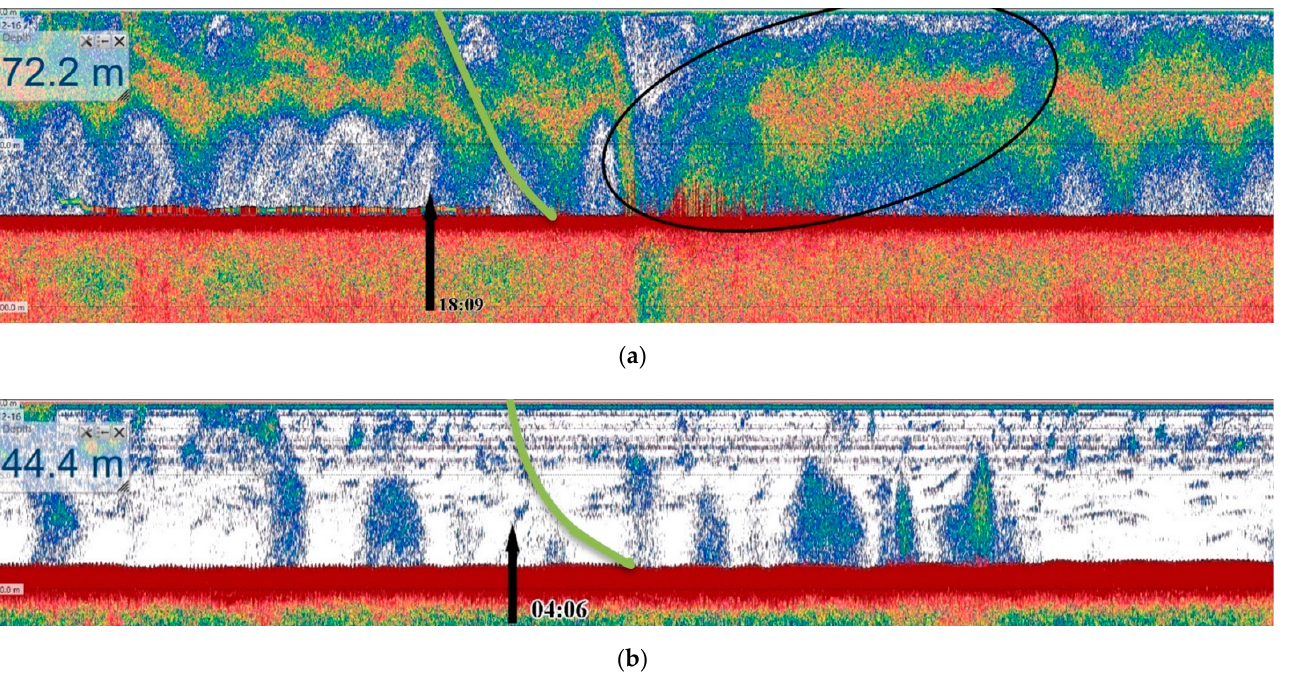
Figure 9. Echograms of drift were obtained at stations ( a ) No. 6947 and ( b ) No. 6962. An arrow marks the start time of the hologram recording. An oval indicates a section of the water column with a significant number of bubbles. A green line shows the estimated trajectory of the camera as it drifts.